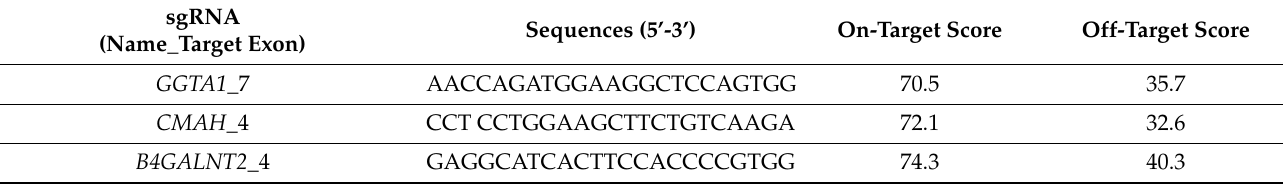
Table 1. List of target single-guide RNAs (sgRNAs).